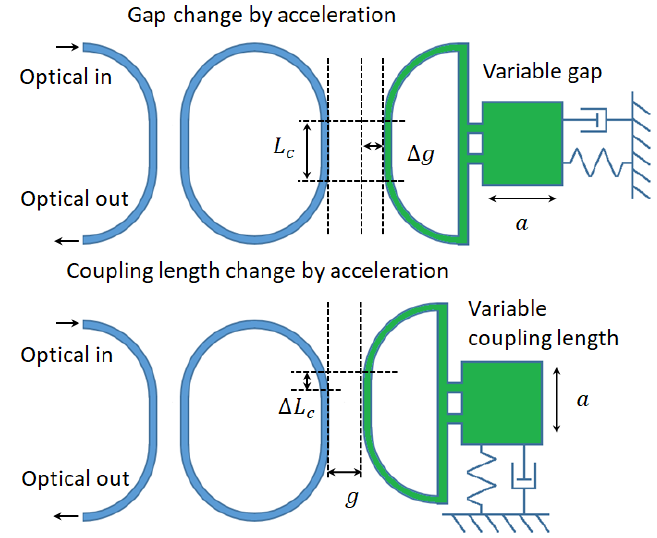
Figure 1. Two accelerator constructions based on a single ring resonator.